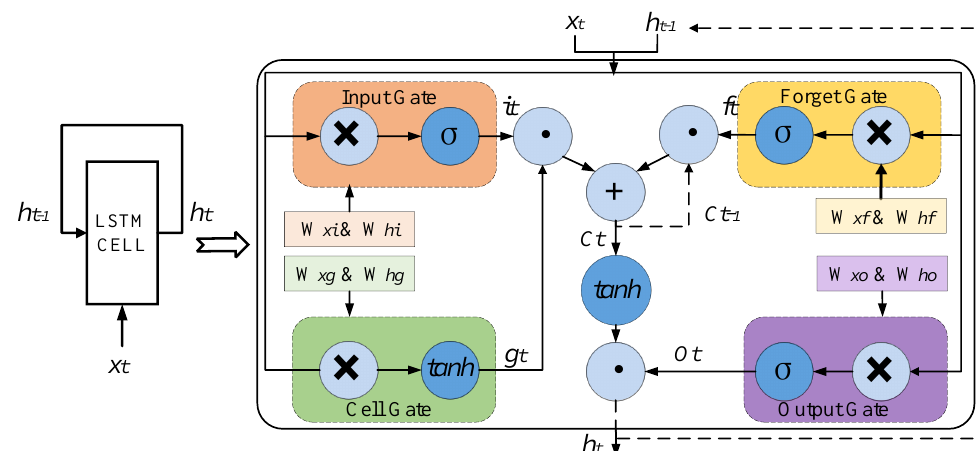
Figure 1. The structure of the LSTM neural